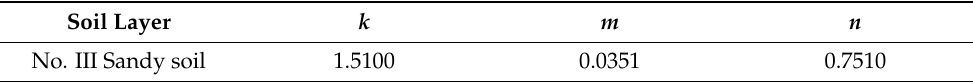
Table 9. Parameters of empirical creep model of sandy soil in Changsha.